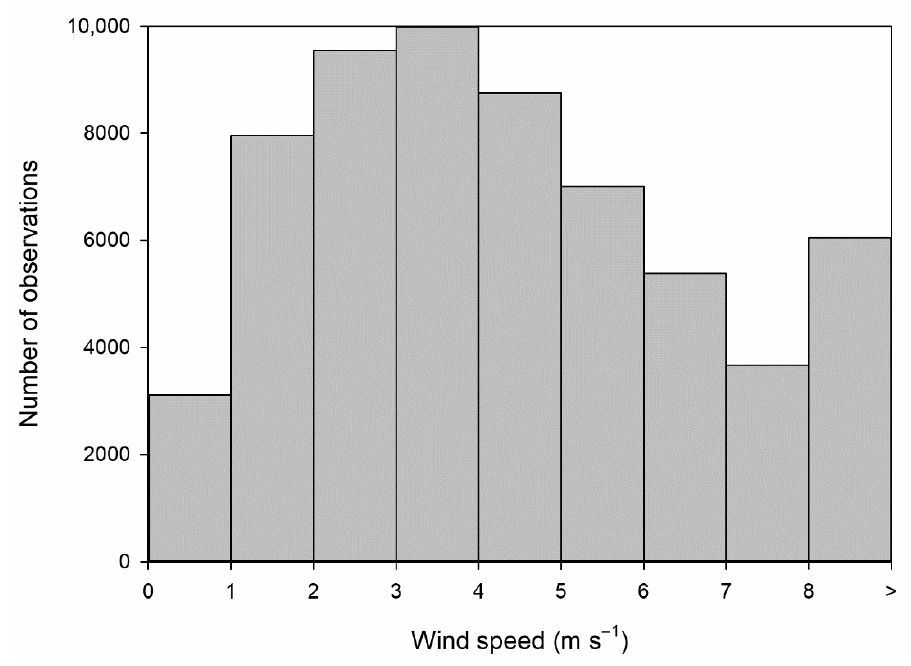
Figure 2. Wind speed distribution.